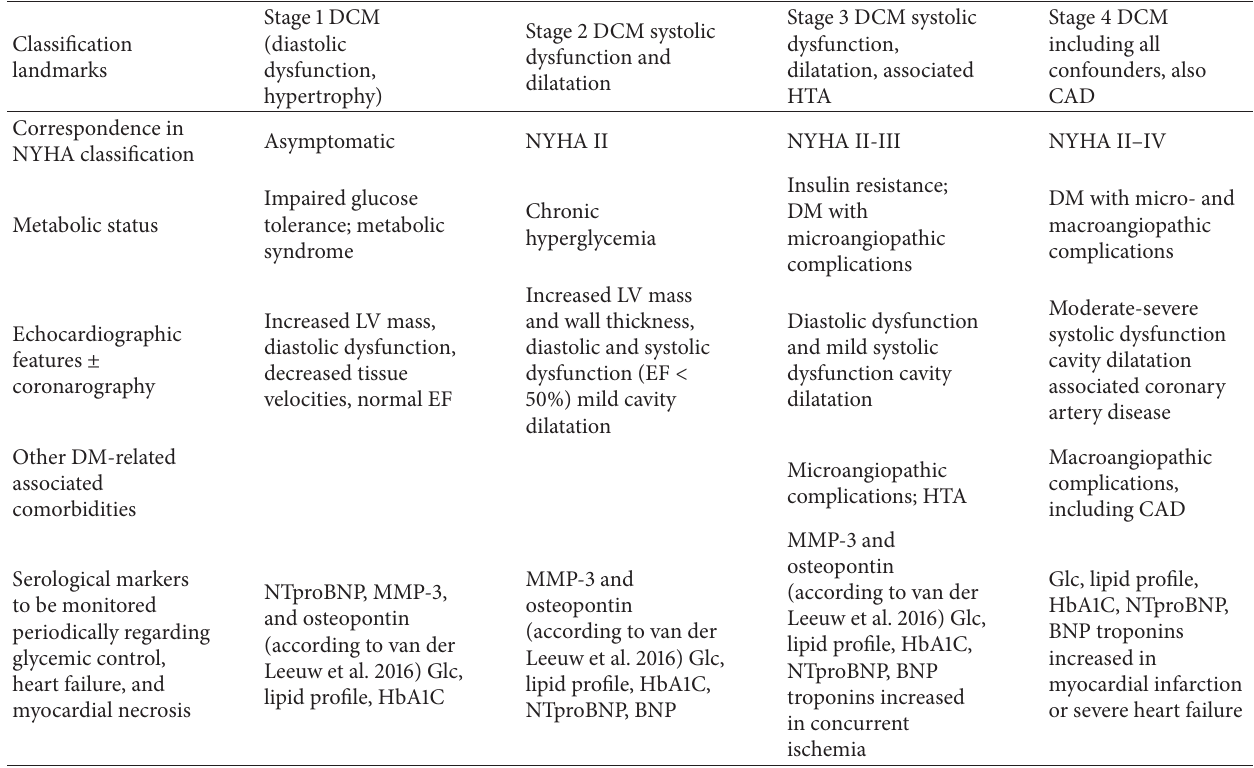
Table 1: DCM classification (adapted from Maisch et al.,